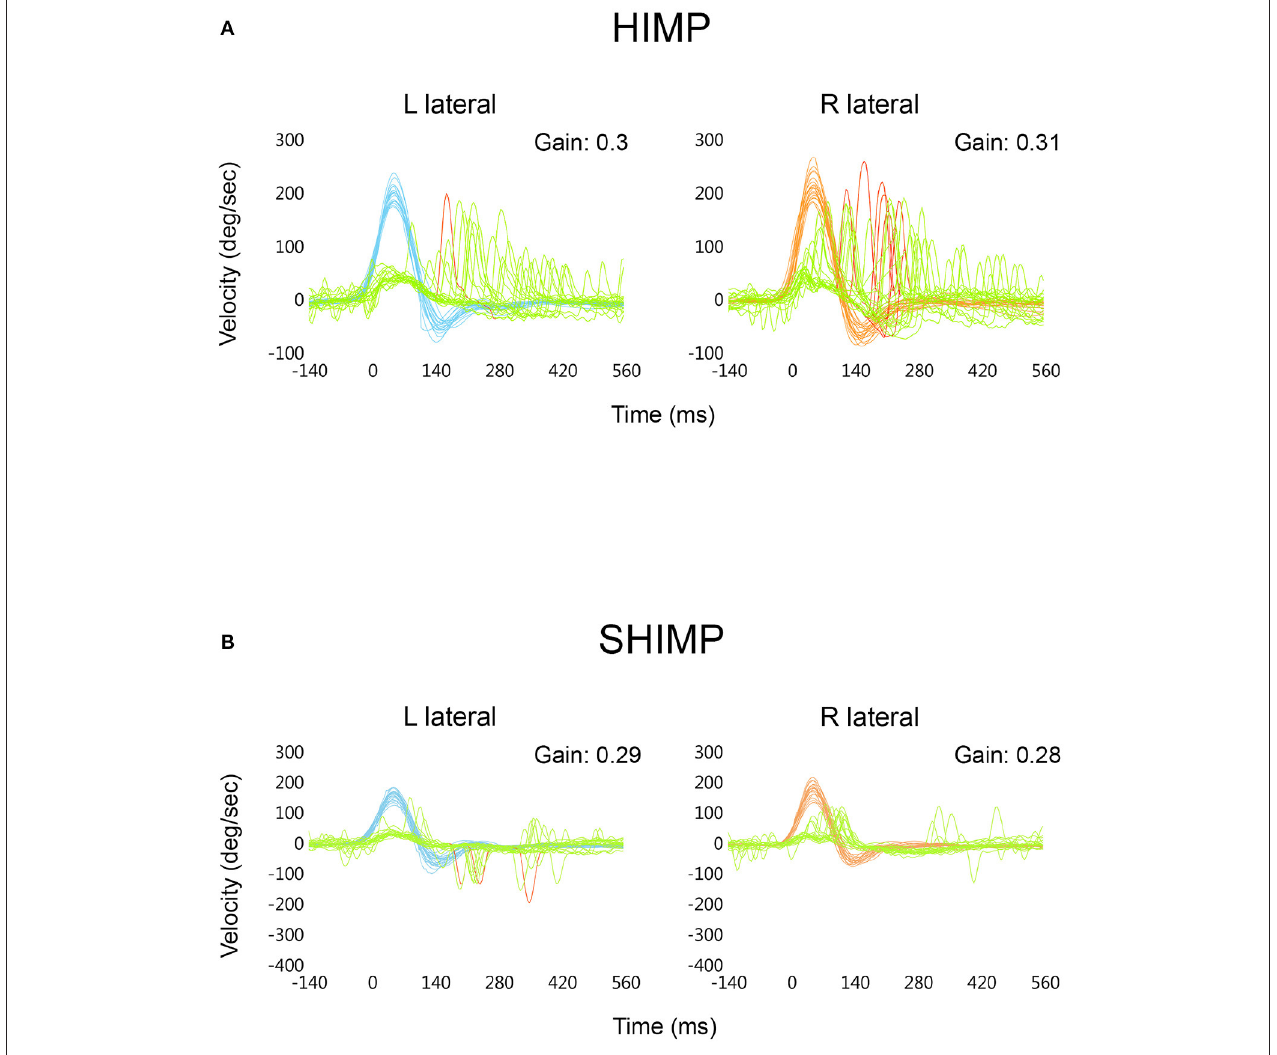
FIGURE 4 | vHIT comparison of superimposed head [right: red; left: blue] and eye [green] velocity expressed in degrees/second ( y axis) vs. time in ms ( x axis) during HIMP trials of both lateral SCCs with the “Spontaneous Nystagmus” check box selected. Included are mean VOR gain values obtained at 2 months of follow-up (A) . Similar vHIT comparison of superimposed head and eye velocity in degrees/second ( y axis) vs. time in ms ( x axis) during SHIMP trials; “Spontaneous Nystagmus” check box selected. Included are mean VOR gain values obtained at 2 months of follow-up (B) .